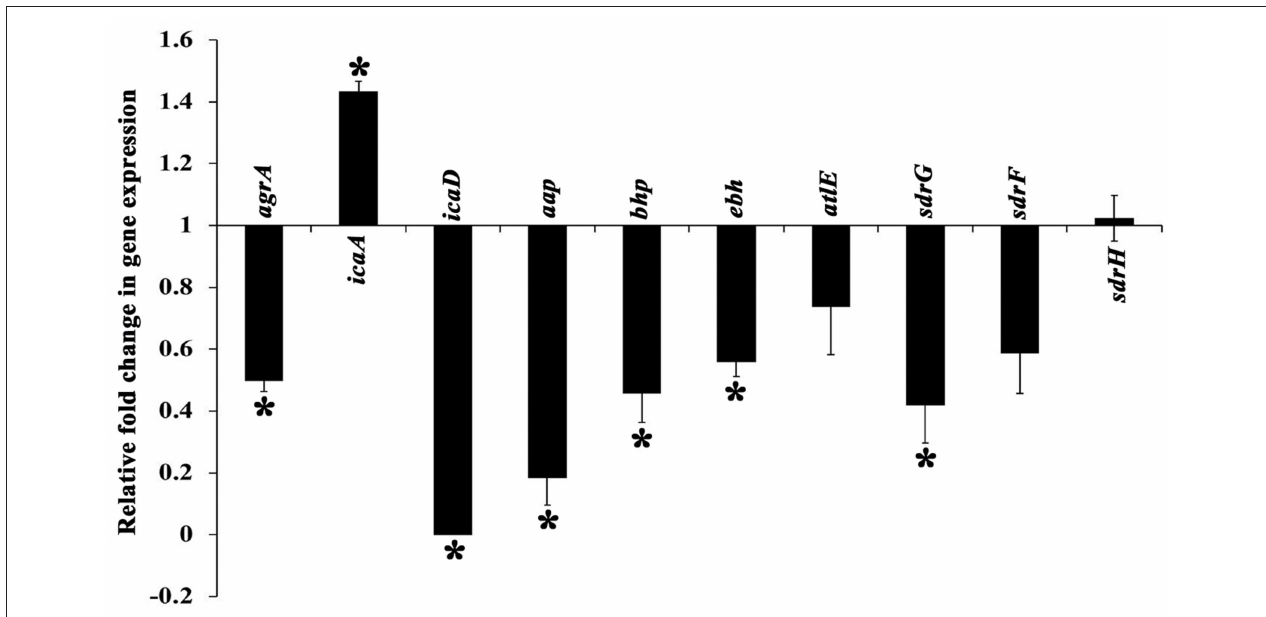
FIGURE 8 | Differential gene expression profile of MRSE in the absence and presence of UMB (at 500 µ g/ml). The expression profile of candidate genes entailed in biofilm formation and virulence factor production was found to be down regulated upon UMB treatment. The housekeeping gene, rplU was considered as the internal control. Error bars represent standard deviations. *Statistical significance between control and treated samples from three independent experiments ( p < 0.005).